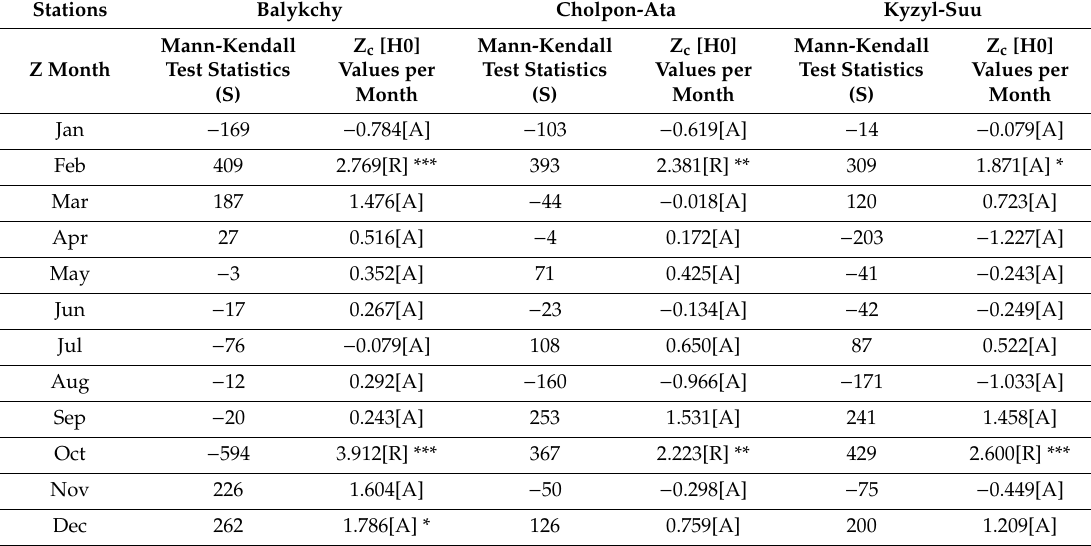
Table 2. The results of the monotonic Mann-Kendall trend test for monthly precipitation in the Lake Issyk-Kull